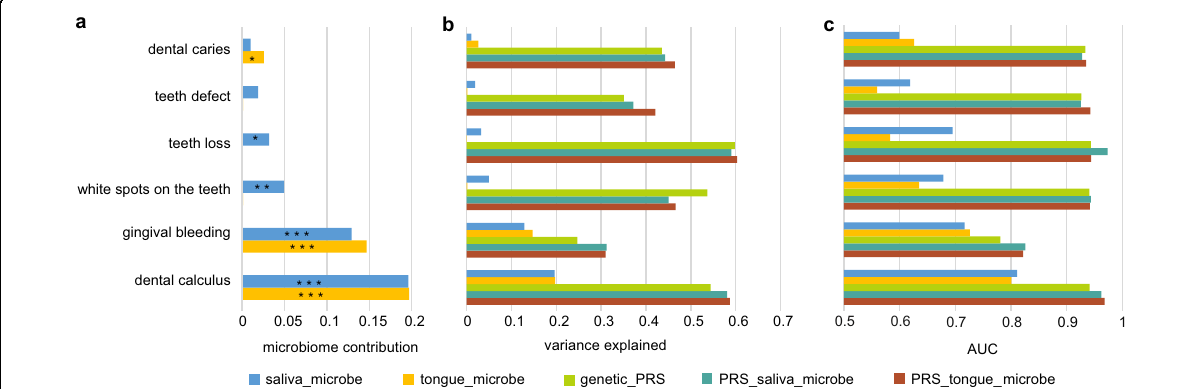
Fig. 6 Oral microbiome and genetic PRS infer a signi fi cant fraction of the variance of dental diseases. a R 2 estimates of six dental diseases and their signi fi cance contributed by the oral microbiome, evaluated using a linear model in the lightGBM package. * p < 0.05, ** p < 0.01, and *** p < 0.001. b Predictive ef fi ciency of six dental diseases (measured using the coef fi cient of determination ( R 2 )), evaluated using a linear model under fi ve different sets of predictive features: (i) relative abundances of salivary microbial taxa; (ii) relative abundances of tongue dorsum microbial taxa; (iii) PRS calculated as an unweighted sum of risk alleles from independent and signi fi cant SNPs (LD r 2 < 0.2, p < 10 − 5 ) for each oral disease; (iv) “ PRS + salivary microbiome ” : PRS, relative abundances of salivary microbial taxa, and (v) “ PRS + tongue microbiome ” : PRS, relative abundances of tongue dorsum microbial taxa. c The discriminative ef fi ciency for six dental diseases (measured using the area under the curve (AUC)), evaluated using a discriminative model under the fi ve different sets of predictive features as described in b